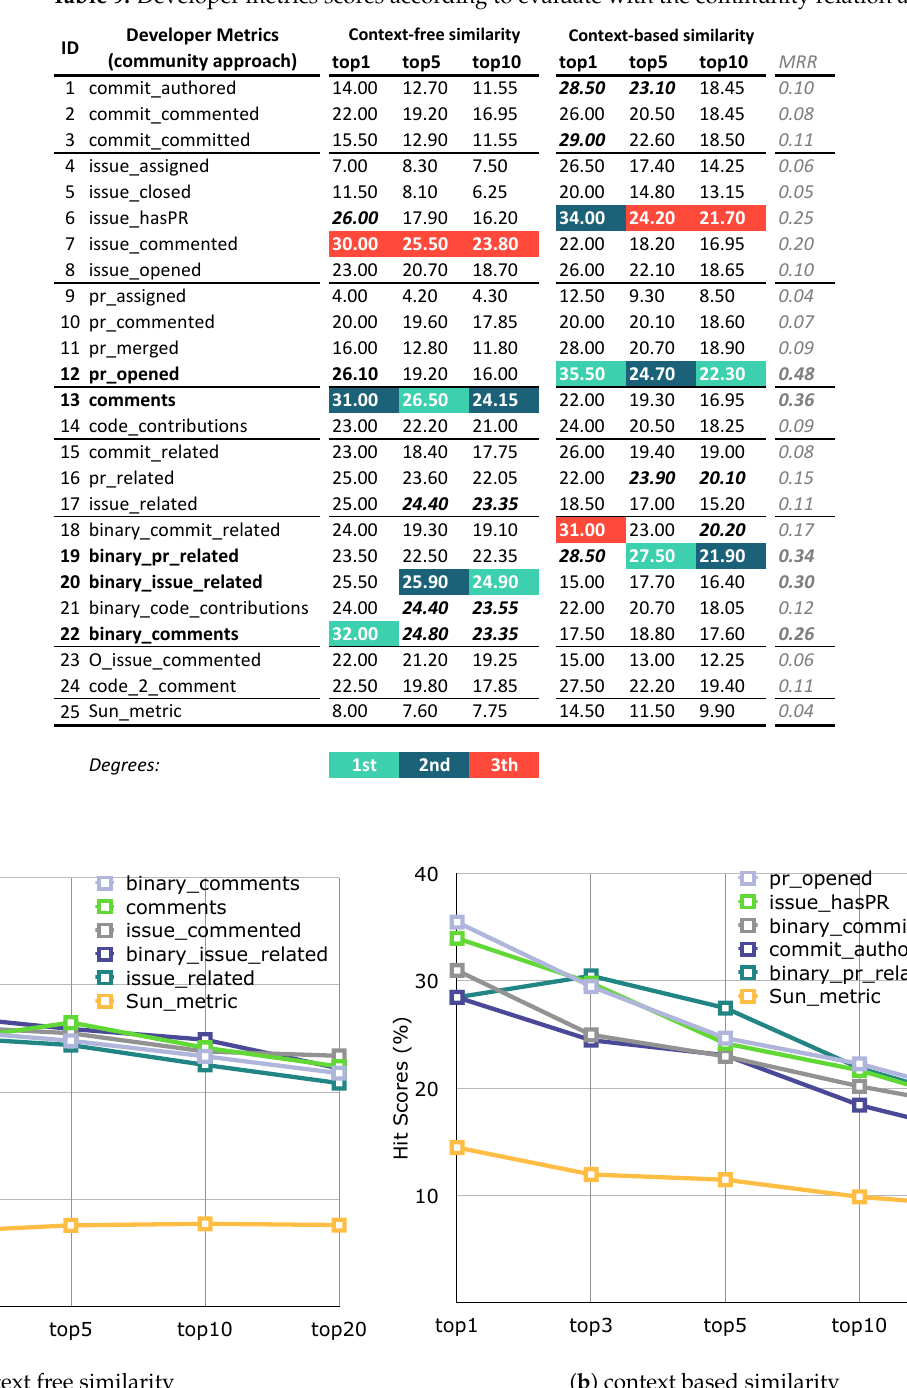
Table 9. Developer metrics scores according to evaluate with the community relation approach.